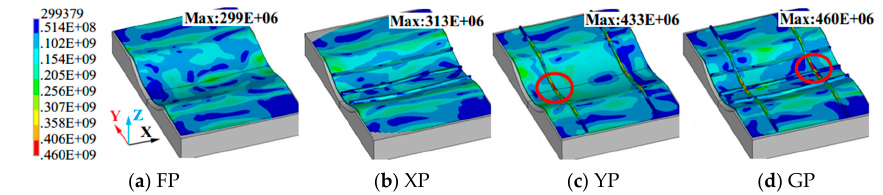
Figure 11. Residual stress distribution of four panels after springback (Pa).